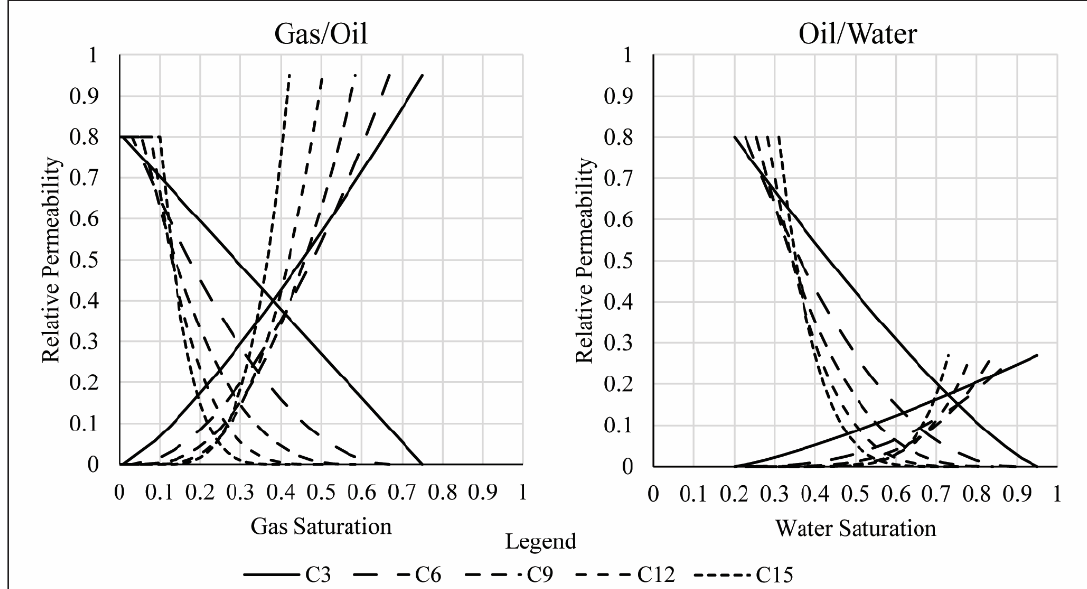
Figure A1. The C3, C6, C9, C12, and C15 relative permeability curves. The saturation endpoints and curvature are varied, while the relative permeability end points remain constant.